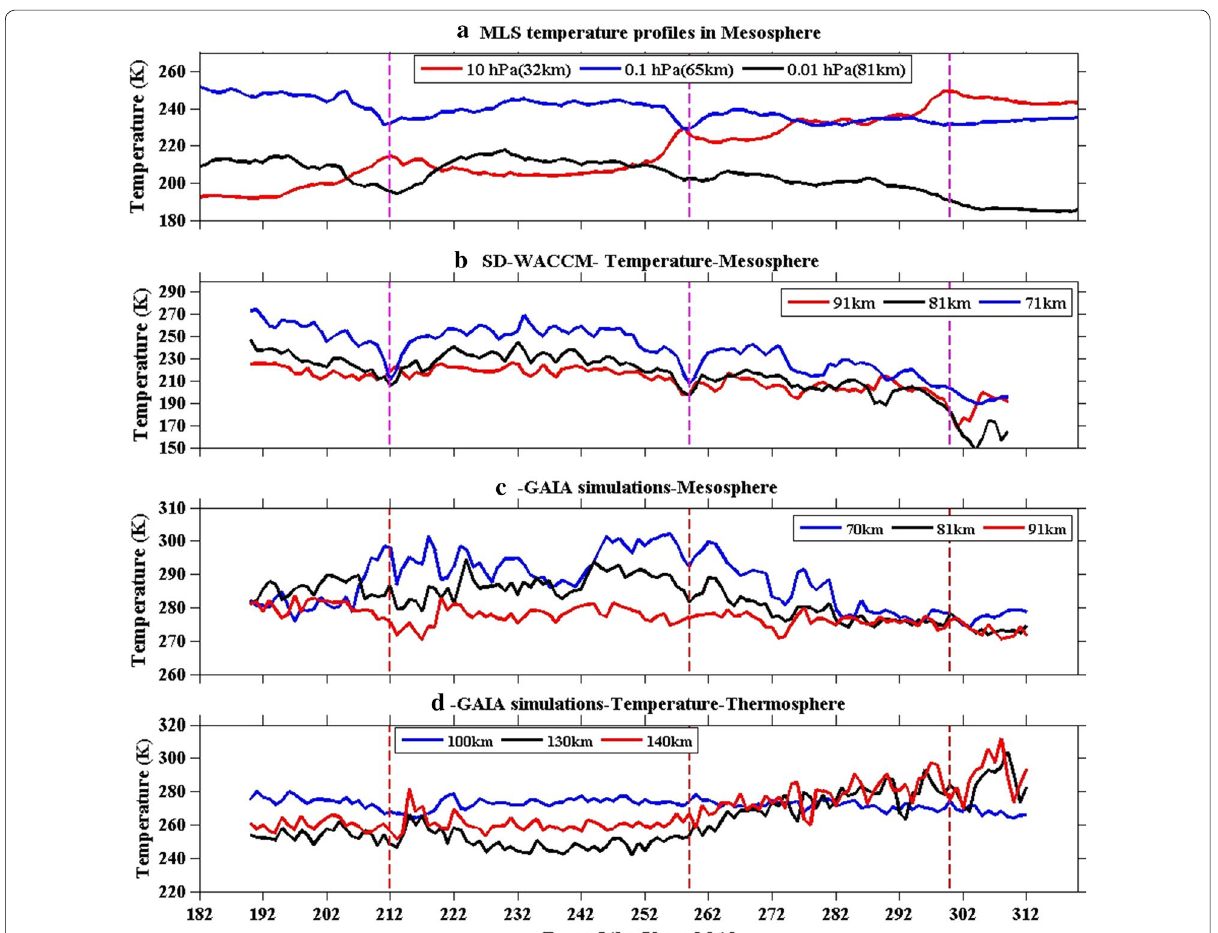
Fig. 3 a Daily mean temperatures observed at 10, 0.1 and 0.01 hPa using MLS measurements at ~80°S during 2010 SH winter. b SD-WACCM simula- tions of zonal mean zonal temperatures (75–90°S) at the altitudes 71, 81 and 91 km from day 182 to 314 of 2010. c Same as b but at the altitudes 70, 81 and 91 km from GAIA simulations at ~70–82°S. d GAIA simulations of lower thermospheric temperatures at 100, 130 and 140 km. The dashed vertical lines indicate the days of peak